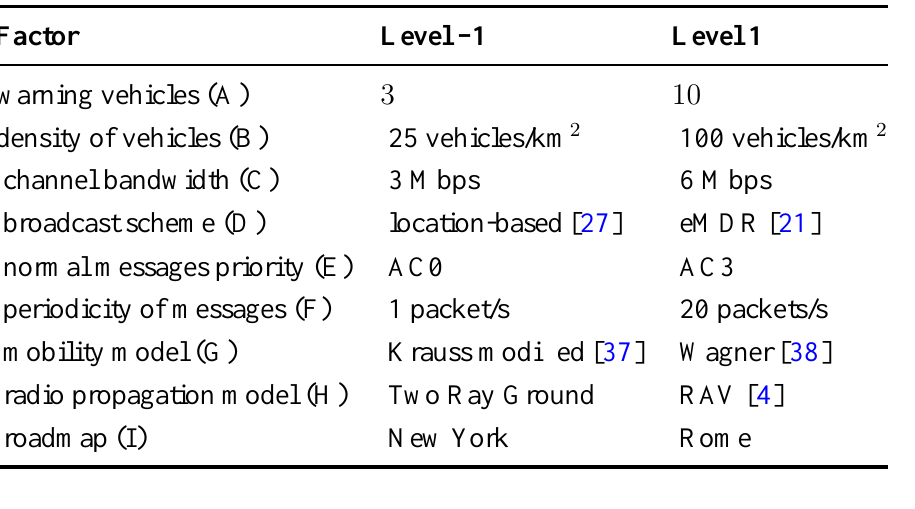
Table 5. Factors considered and their